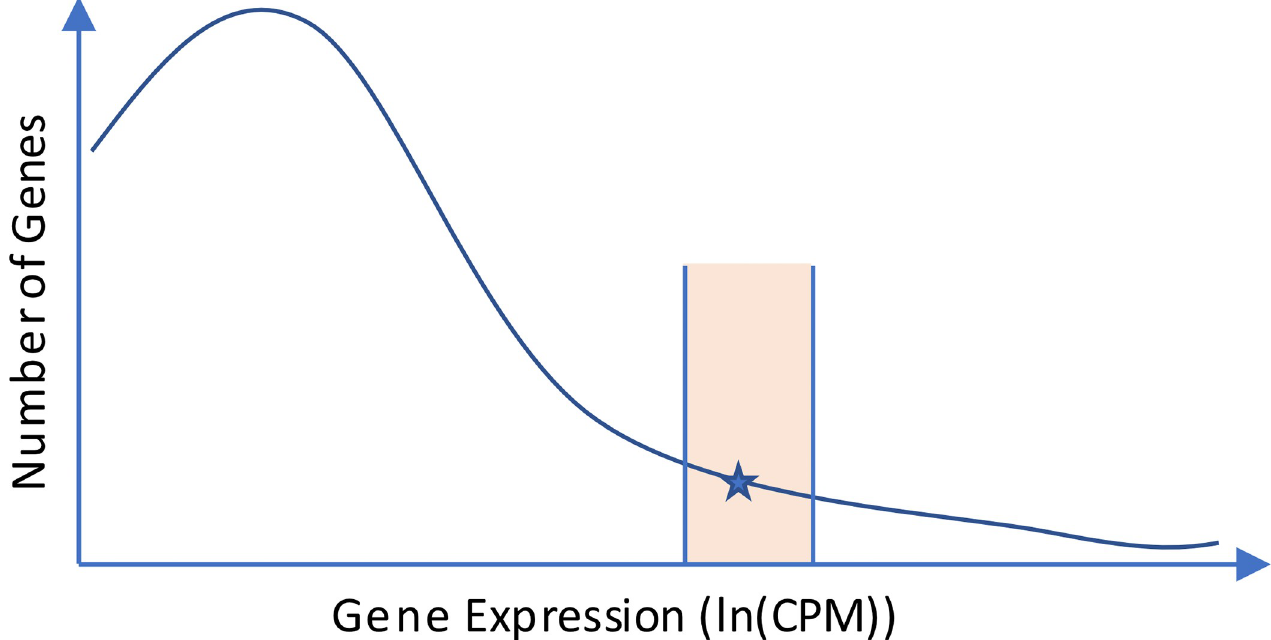
Fig 3. Schematic visualization of how the variation per gene expression range is calculated. 1000 points are logarithmically distributed between 10 and 1000 CPM. For each point, a range is determined based on the template cell population. The range (shaded region) for a point (the star in the figure) is defined to cover 500 genes such that the geometric mean of their expression lies as close to the point as possible. The bounds 10–1000 CPM were determined empirically. For genes below 10 CPM, the spread in variation was generally high in comparison to the difference in variation between the aligned and SNO cell populations. Above 1000 CPM, the low frequency of genes resulted in large expression ranges that were no longer appropriate to represent with a single CPM value. The range width of 100 genes was also determined empirically; 500 genes produces a stable variation metric while still maintaining a reasonable representation of the CV